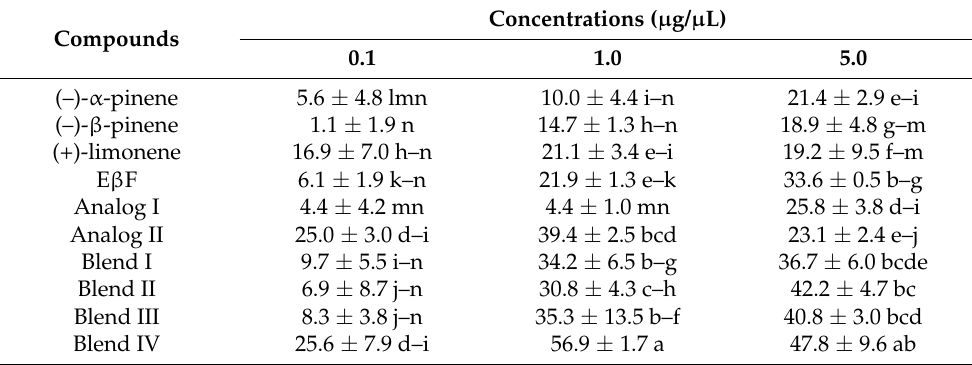
Table 1. Mean ( ± SE) preference index (PI *) for D. rapae to aphid alarm pheromone components and